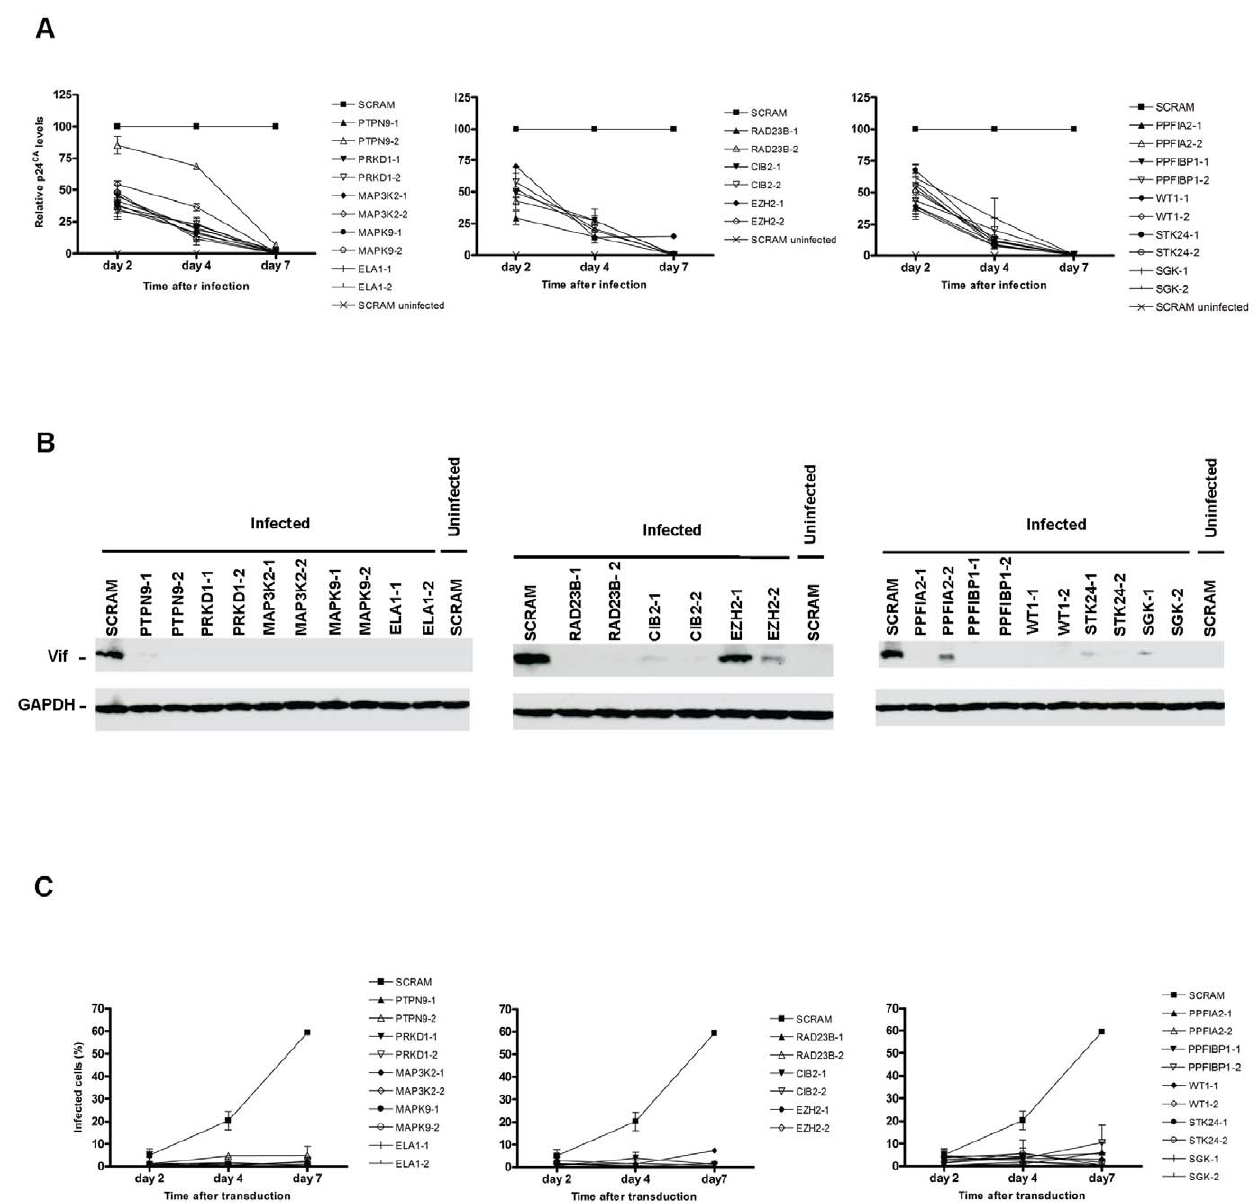
Figure 3. Neutralization of HIV-1 replication by shRNAs is cumulative over time. A . Kinetics of HIV-1 NL4-3 replication in shRNA Jurkat clones during 7 days of infection. shRNA clones were infected with HIV-1 NL4-3 (MOI of 1) and p24 CA antigen was measured at day 2, 4 and 7. Values are relative to control shSCRAM cells infected with HIV-1 ( & ) and represent mean 6 SEM ( n =3). B . Immunoblotting of Vif protein in the different shRNA clones after 48 h of HIV-1 NL4-3 infection (MOI of 1). This figure is representative of three independent experiments. C . Flow cytometry analysis of HSA surface expression in shRNA clones infected with HIV-HSA (MOI of 1) during a time course assay of 7 days of infection. Cells were membrane stained with anti-HSA antibody for detection of HIV-1 infection. Percentage of infected cells was analysed by flow cytometry. Values correspond to mean 6 SEM ( n =2).